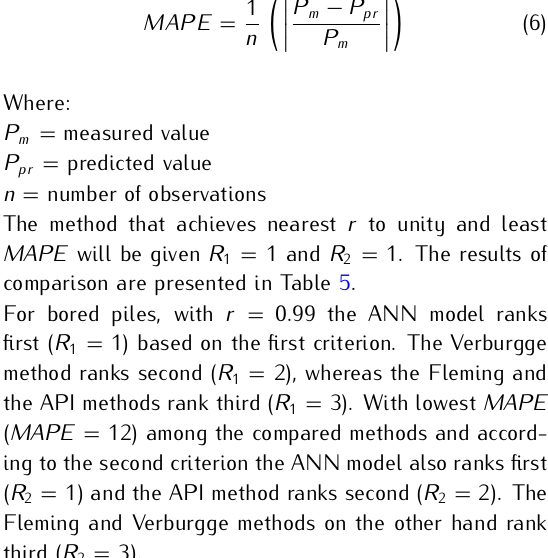
ranking criteria are used: the best fitting criterion ( R 1